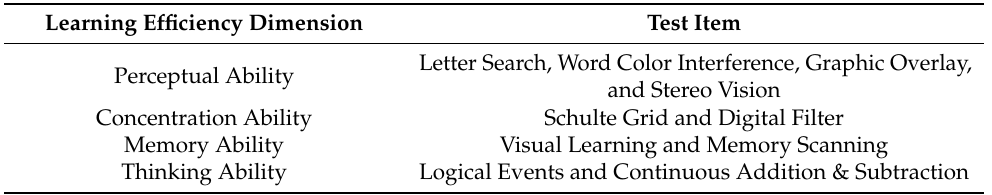
Table 5. Four dimensions and main test items of the APCD